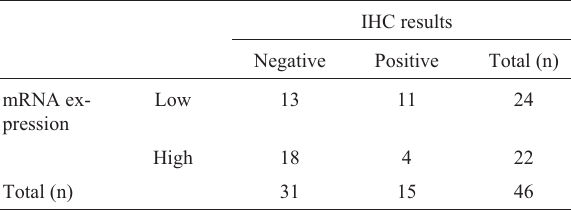
Table 3 - Correlation between IGFBP5 mRNA (RT-PCR) and protein (immunohistochemistry - IHC) expression